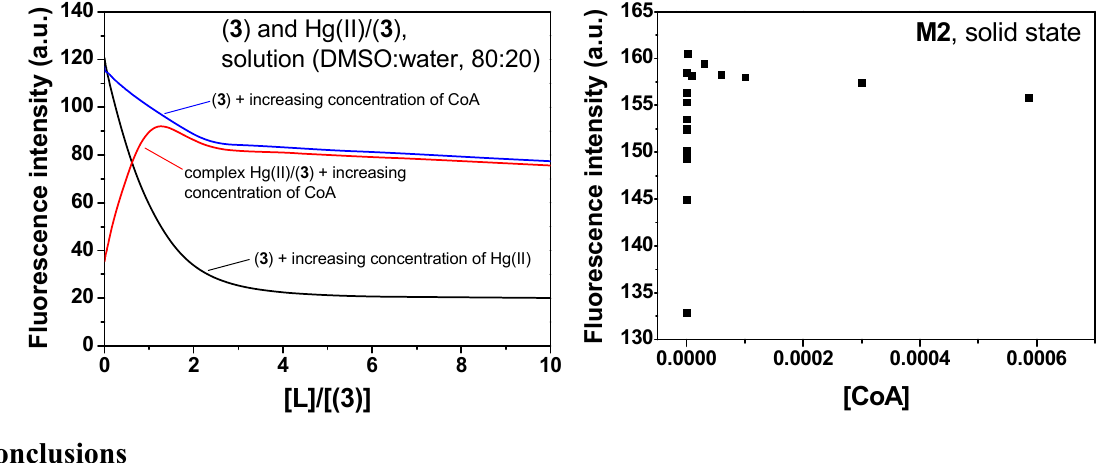
Figure 7. Cross interaction CoA, Hg(II) and ( 3 ) in DMSO:H interaction of the hybrid membrane M2 with CoA in water (pH = 7.4, TRIS)